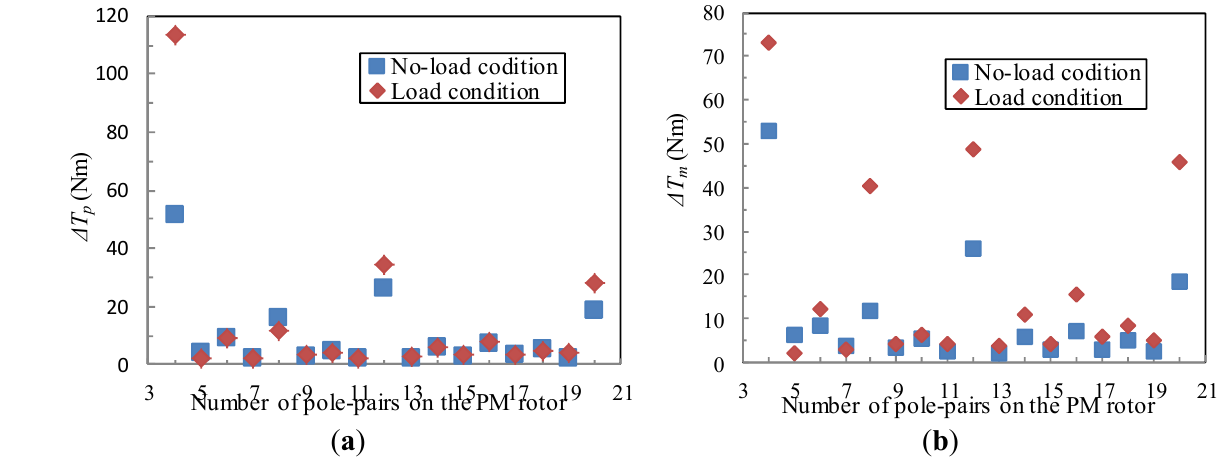
and Δ T with the number of pole pairs of the PM rotor: Figure 14. Variation of Δ T p m and ( b ) Δ T ( a ) Δ T p m